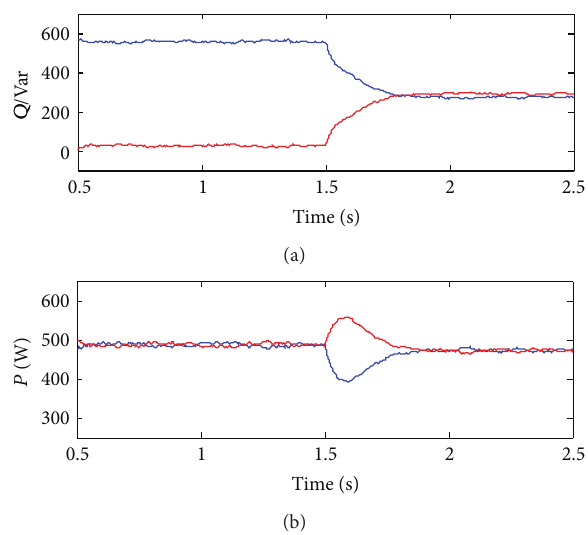
Figure 10: Simulation results of power sharing with conventional and proposed control. (a) Reactive power. (b) Active power.